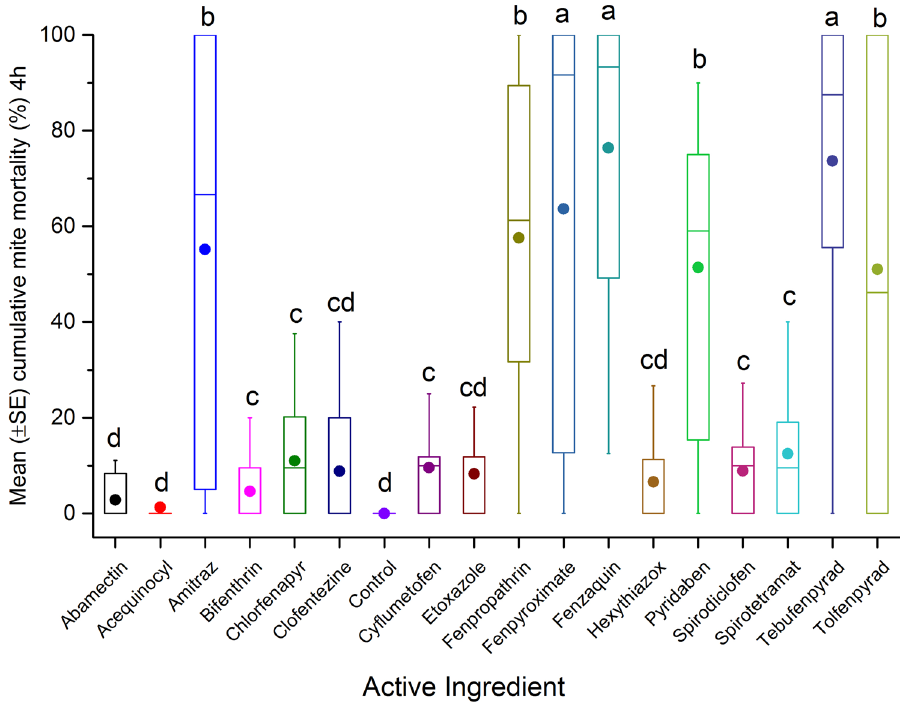
Figure 1. Mean (± SE) cumulative mite mortality (%) during 4 h exposure to different dilutions (0.1 mgL −1 , 1 mgL −1 , 10 mgL −1 , 100 mgL −1 , 1,000 mgL −1 , or 10,000 mgL −1 ) of tested AIs in acute surface contact toxicity assay using 20 mL borosilicate glass scintillation vials. A group of mites was treated with different dilutions of amitraz as reference control, or left untreated (control) as negative control. The boxplots present the standard error (length of box), mean (solid circle), median (horizontal line), 5th and 95th percentiles (lower and upper vertical lines). Each box indicates average mortality for replications of each AI (n = 24) or control (n = 4). Means with the same letter among treatments are not significantly different ( p >